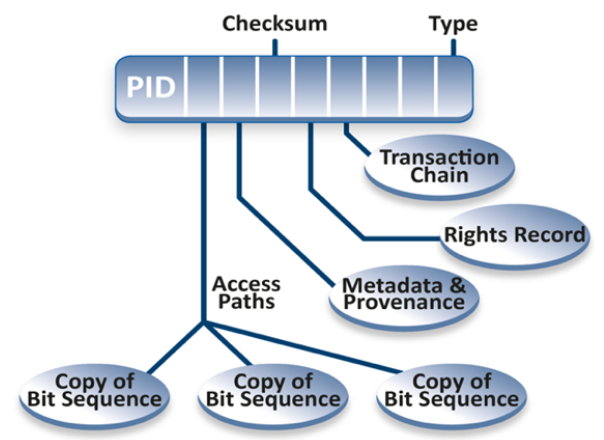
Figure 5. Components and pointers in a Digital Object [13].